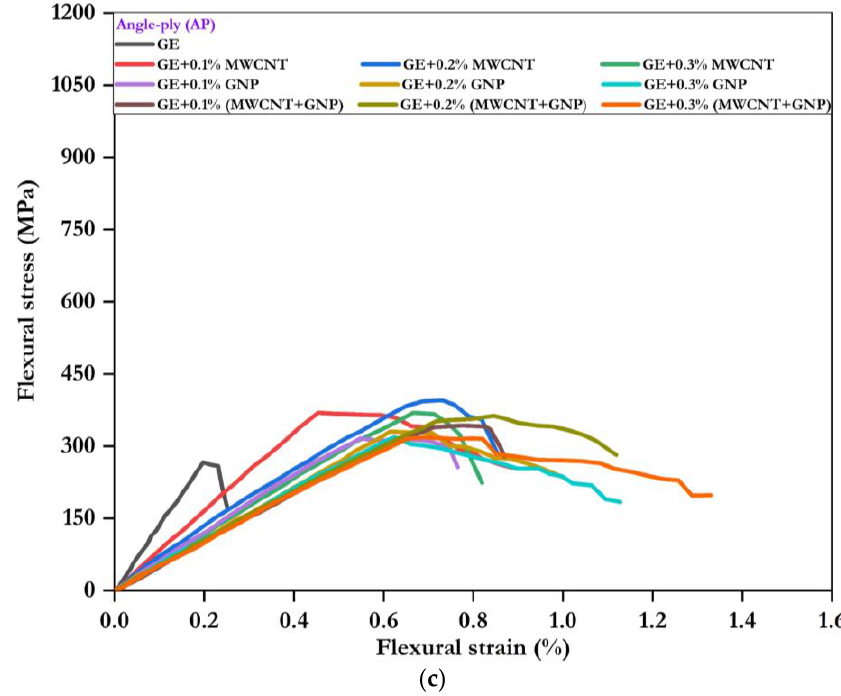
Figure 10. Flexural stress – strain response: ( a ) UD, ( b ) CP, and ( c ) AP.